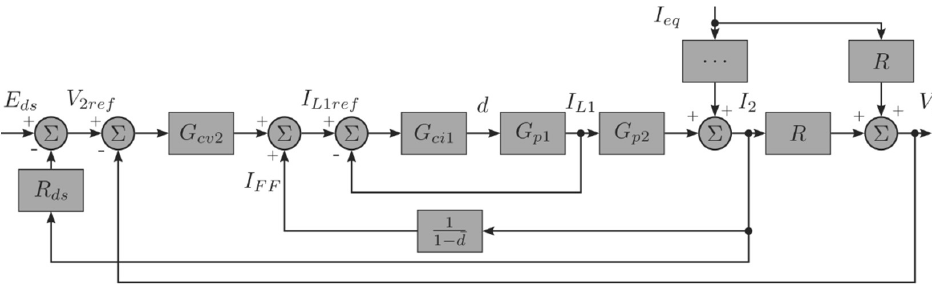
Figure 3. Control scheme that is used for the voltage control of the ESS converter in scenarios #1 (SS-GN), #2 (SD-GN), and #3 (SD-GD).